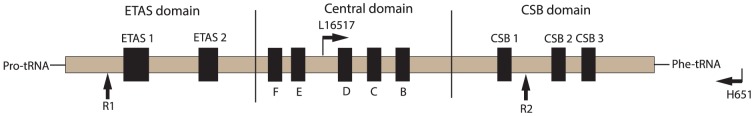
Schematic organization of the bat mitochondrial control region.Two elements in the ETAS domain, five conserved blocks in the Central domain, and two elements in the CSB domain are shown in filled squares. Two repeated sequences (R1 and R2) are located in the ETAS domain and CSB domain, respectively. The locations of the primers used in this study, L16517 and H651, are also shown.